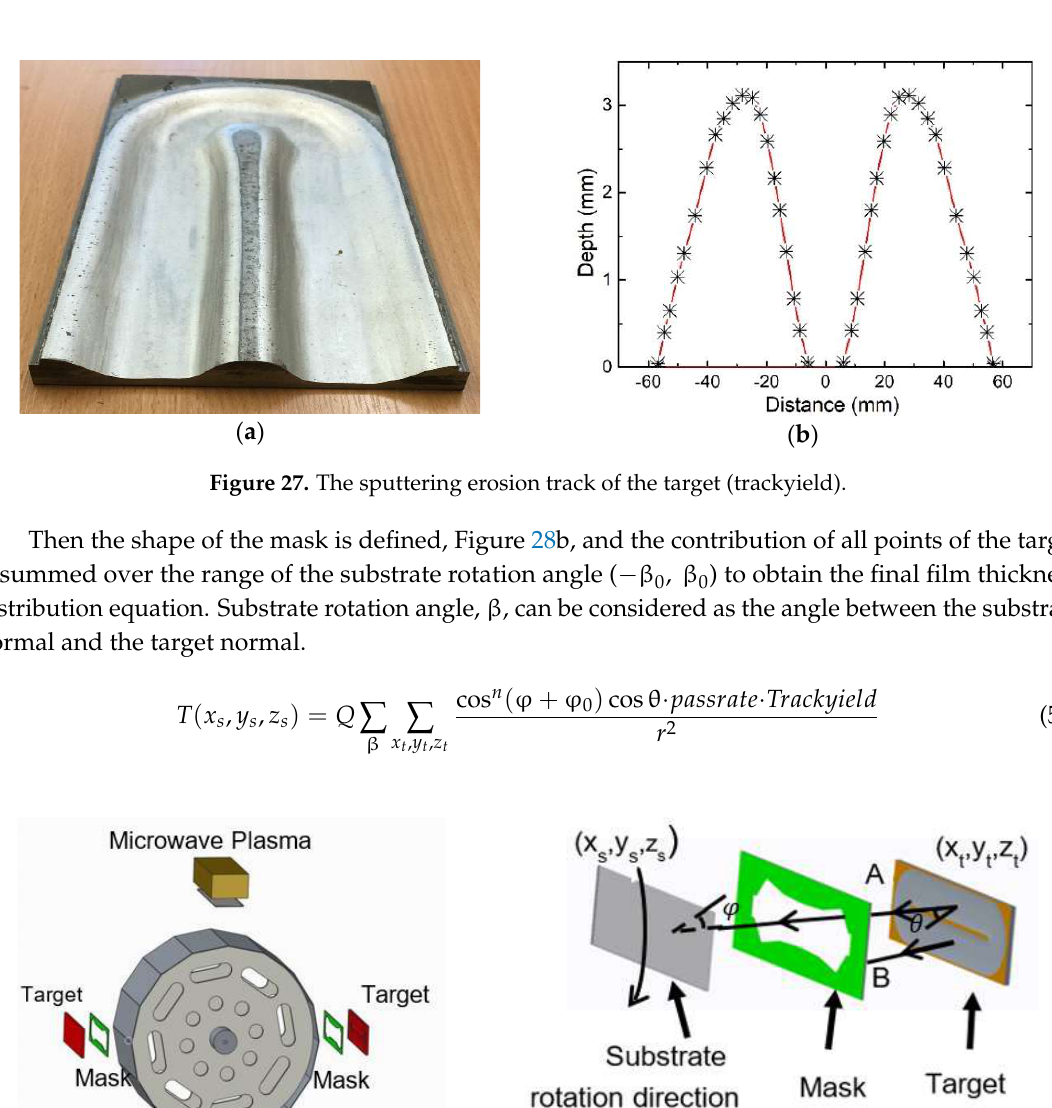
Figure 26. Flow chart for simulation of thickness distribution from sputtering deposition; 𝑝𝑎𝑠𝑠𝑟𝑎𝑡𝑒 is a binary, 0 or 1; trackyield is the sputtering yield of the target.